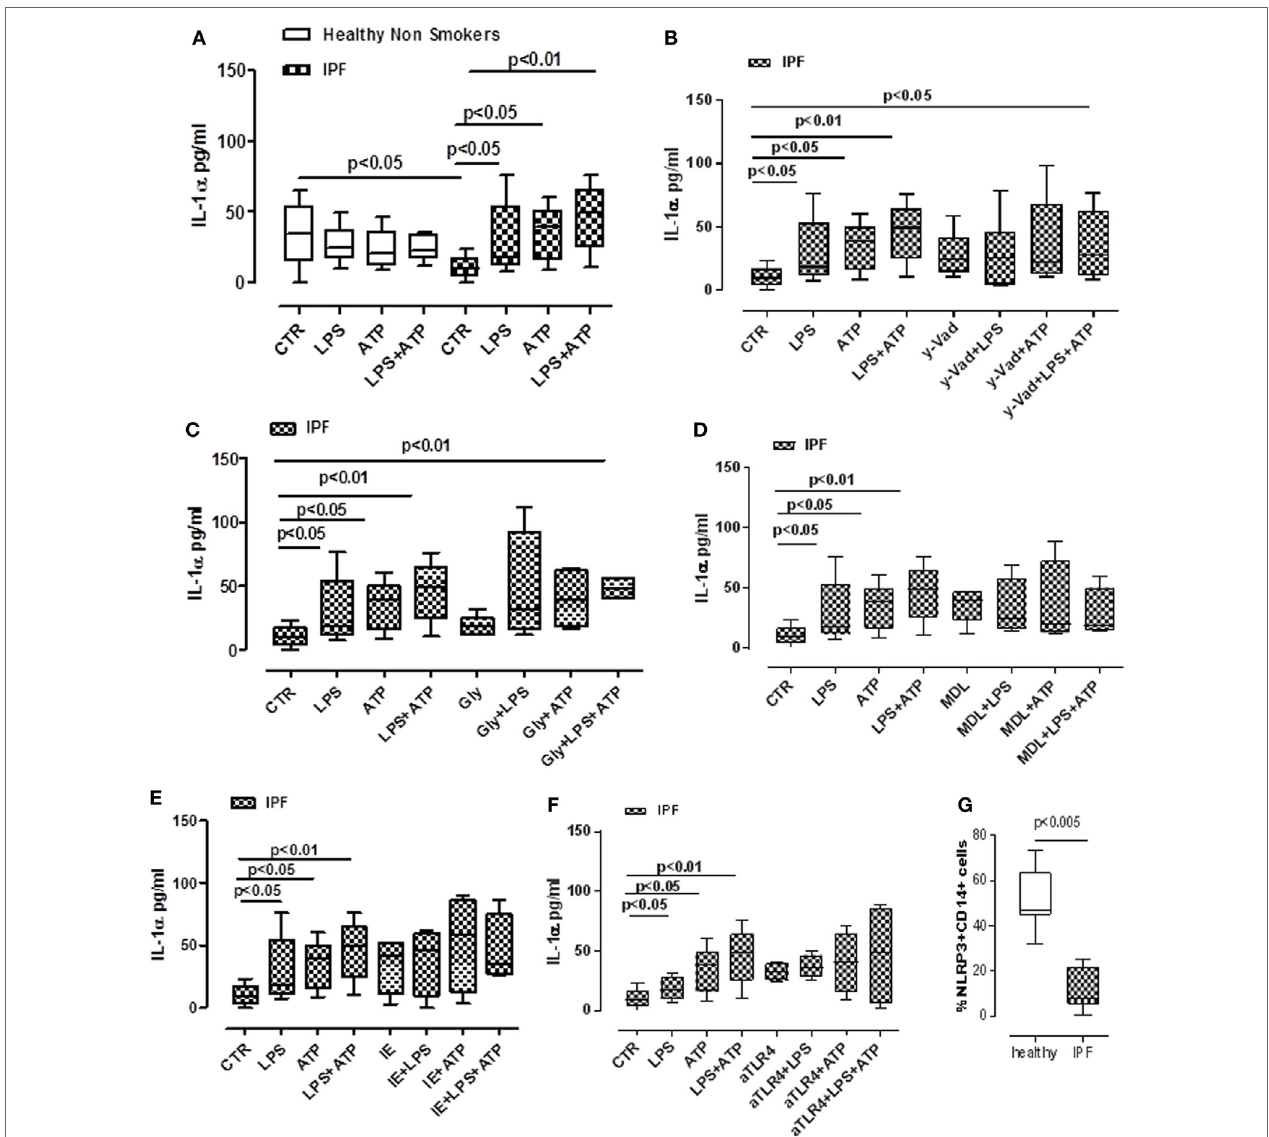
FigUre 2 | Idiopathic pulmonary fibrosis (IPF)-derived peripheral blood mononuclear cells (PBMCs) release IL-1 α in a NLRP3/caspase-1-/caspase-8-/TLR4- and calpain-independent manner. LPS (0.1 μ g/ml) ± ATP (0.5 mM) stimulation (5 h) of PBMCs obtained from IPF patients, significantly increased IL-1 α release